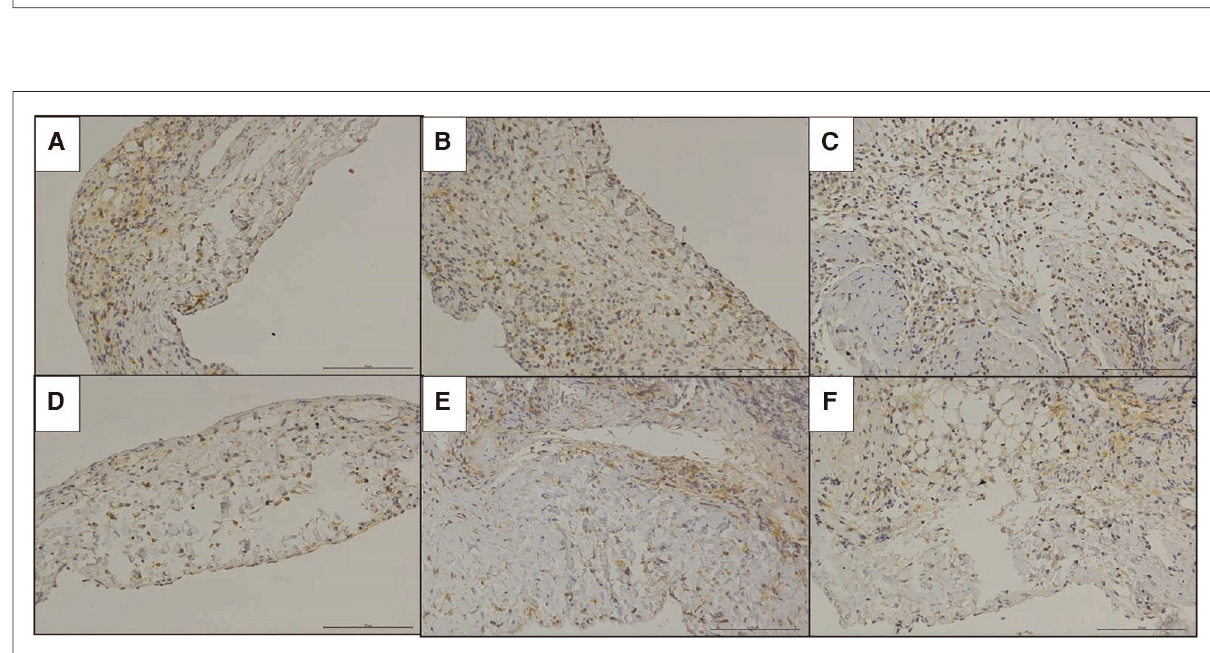
FIGURE 6 Immunohistochemical staining of CD4 in the replaced vessels after operation in two models of vein replacement (X200). ( A ) At 1 week after operation in the cuff group, patchy yellow-stained CD4+ lymphocytes were observed in the every layer of the vessel wall. ( B ) At 2 weeks after operation in the cuff group, a large amount of yellow-stained CD4+ lymphocyte in fi ltration was observed in the every layer of the vessel wall. ( C ) At 4 weeks after operation in the cuff group, locally yellow-stained CD4+ lymphocytes were observed in the wall. ( D ) At 1 week after operation in the suture group, yellow-stained CD4+ lymphocytes were scattered in the wall. ( E ) At 2 weeks after operation in the suture group, yellow-stained CD4+ lymphocytes were mainly concentrated in the adventitial layer of the wall. ( F ) At 4 weeks after operation in the suture group, yellow-stained CD4 + lymphocytes were mainly concentrated in the adventitial layer of the wall.